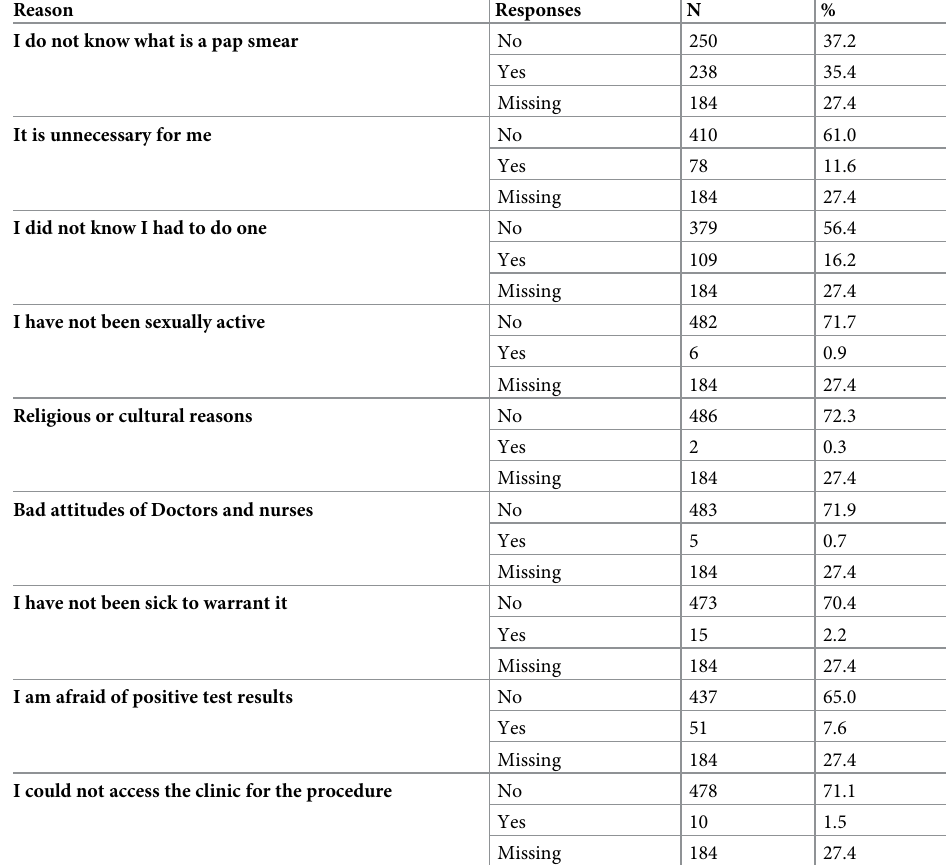
Table 5. Reasons for not taking the cervical cancer-screening test among black women in the past 10 years attend- ing Pap smears in primary health care clinics in Gauteng Province, South Africa (N = 672).